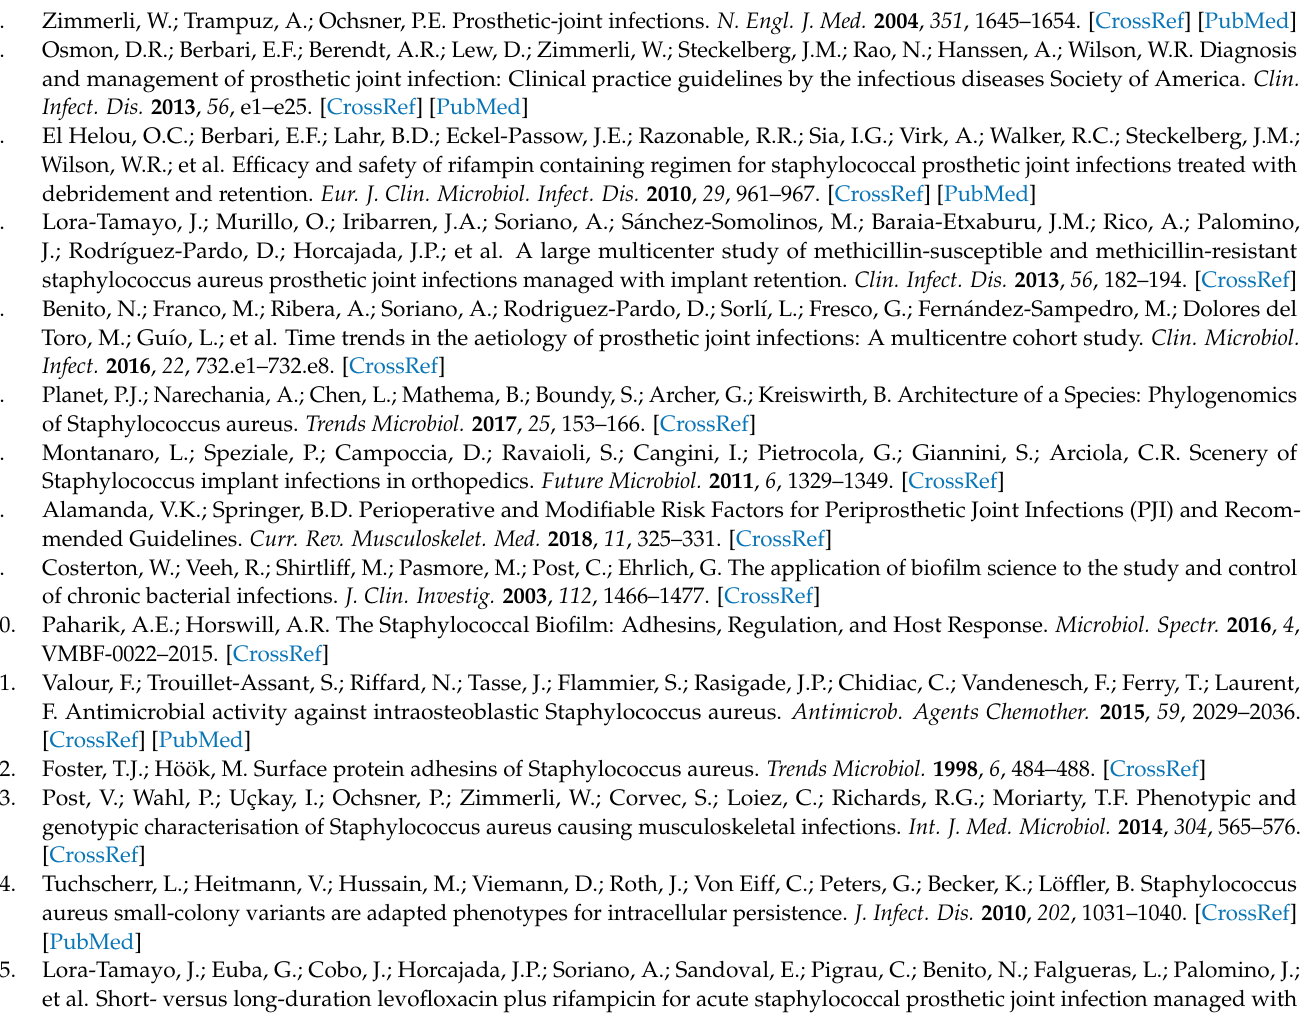
bioinformatic analysis. Table S2: Virulence genes of all the strains causing the 14 prosthetic joint infections included in this